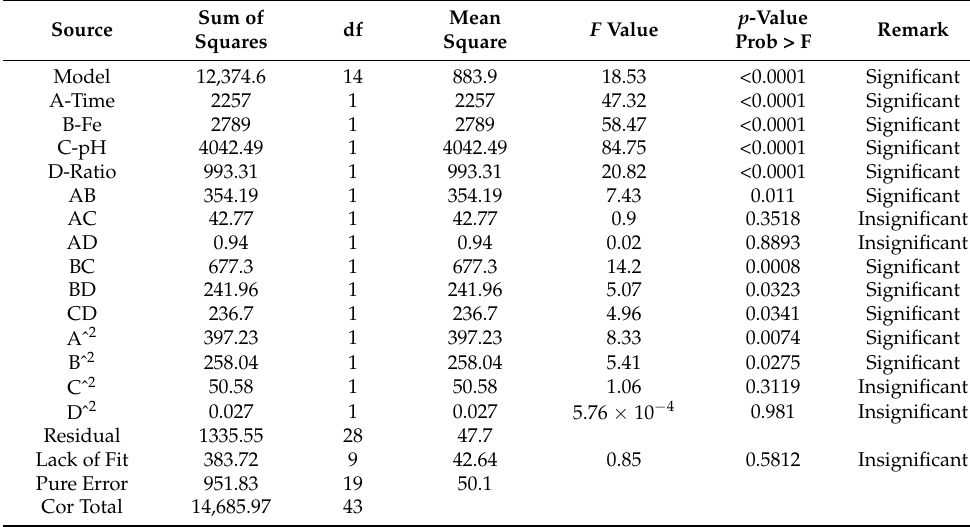
Table 7. Analysis of variance for color removal.